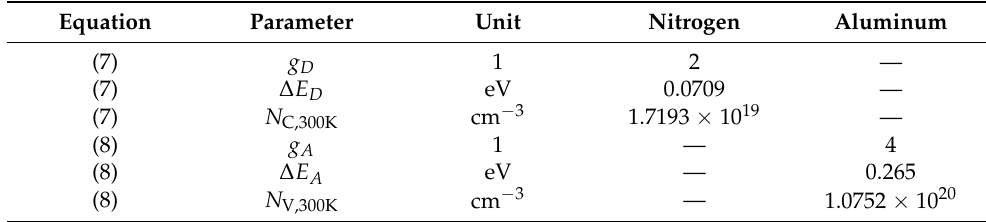
Table A2. Incomplete ionization parameters